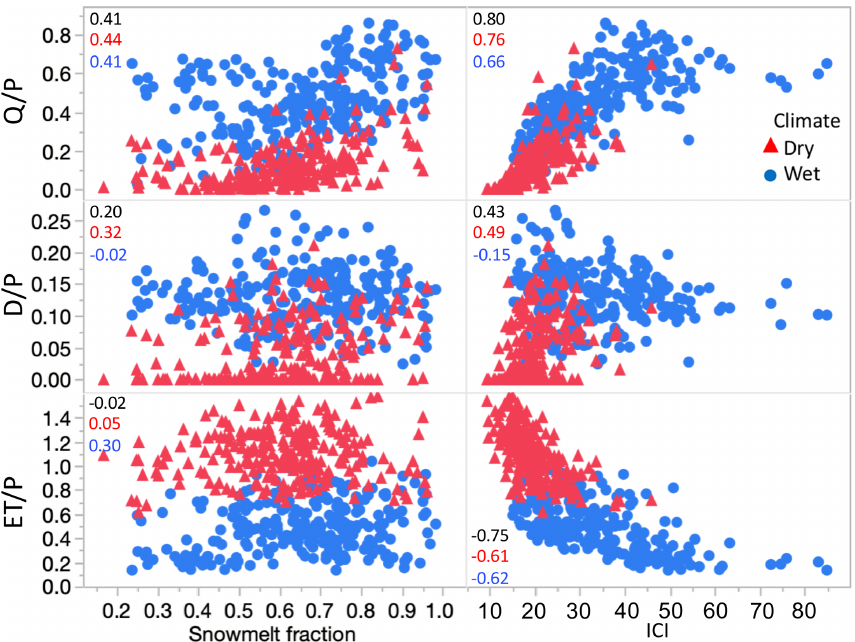
Figure 5. Ratio of runoff ( Q ), deep drainage ( D ), and evapotranspiration (ET) to input ( P ) vs. snowmelt fraction of input and input con- centration index (ICI) at the annual timescale. Data from historical simulations on loam profile. Dry sites P/ PET < = 1, wet P/ PET > 1. Correlation values between explanatory and dependent variables displayed in each panel colored by all (black), dry (red), and wet (blue) classifications. Correlation values also shown in Table